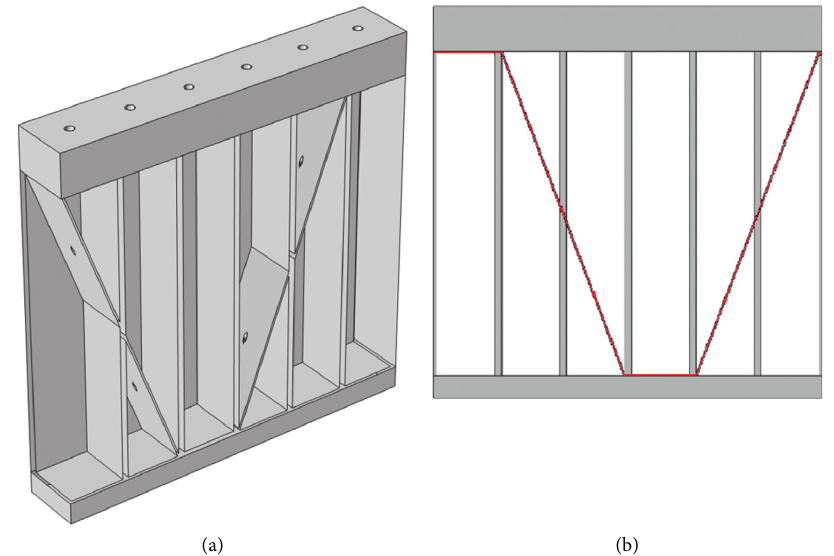
Figure 3: (a) 3D model of six honeycomb cells. (b) 2D model of six